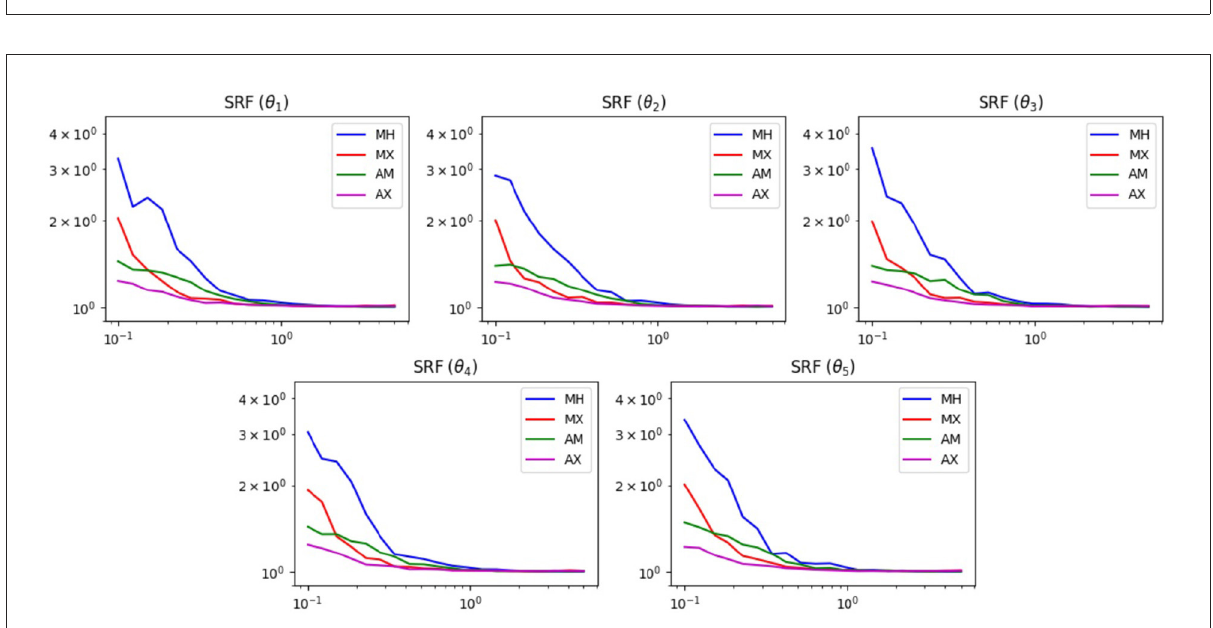
FIGURE5 SRF results of MCMC test on the 5D Ackley function. The horizontal axis displays the proposal width (logarithmic scale). The vertical axis is the SRF (logarithmic scale).